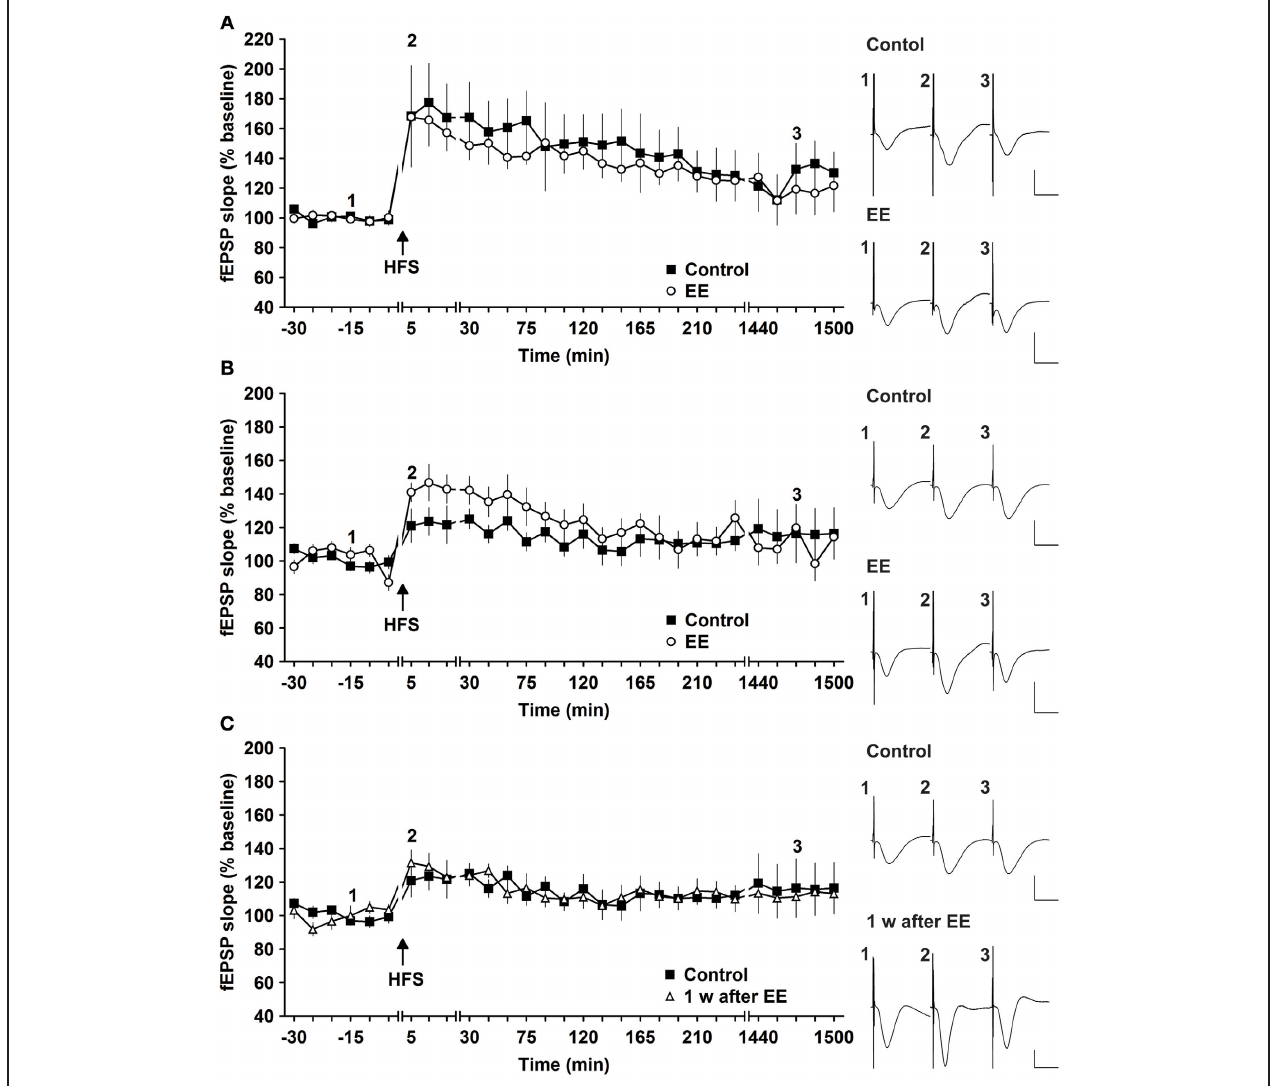
following 14 days of environmental enrichment (EE) under group-housing conditions. (C) Seven days after cessation of EE, fEPSP values returned to control (pre-EE) levels. Time-point of high frequency stimulation (HFS) is marked with a filled arrow. Insets: Analog examples of field potentials (averages of five consecutive sweeps) from typical experiments at the time indicated by the numbers. Horizontal bar: 10ms, vertical bar: